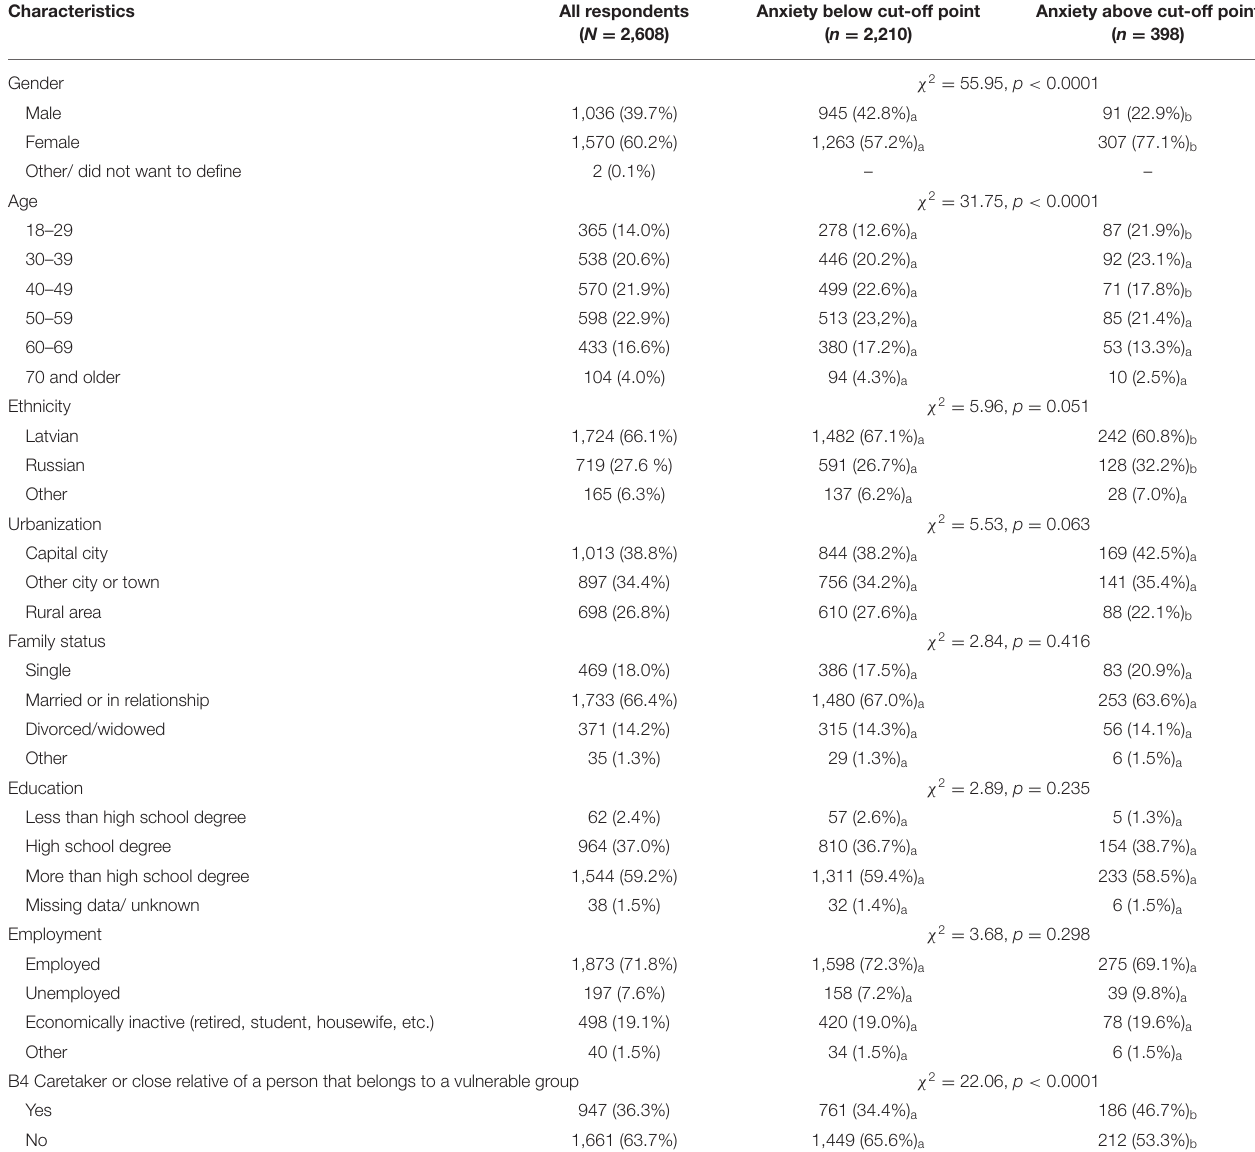
TABLE 1 | Sociodemographic determinants and their association with anxiety ( n = 2,608).